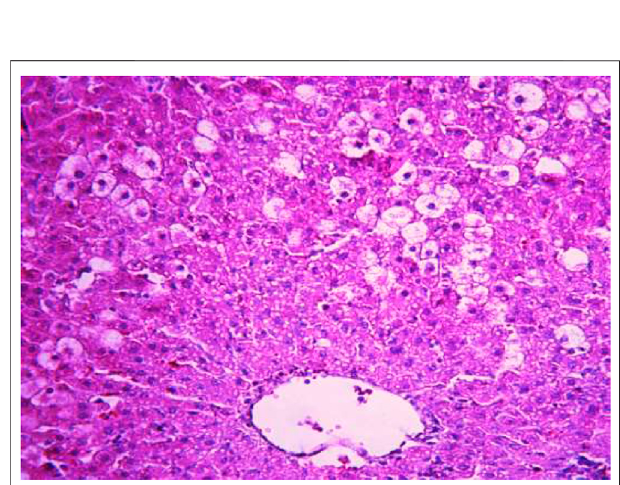
FIGURE 3 | Liver tissue. Negative group. There is a linear cord structure of hepatocytes in the hepatic lobule. Stain: hemotoxin and eosin. Magni fi cation × 400.